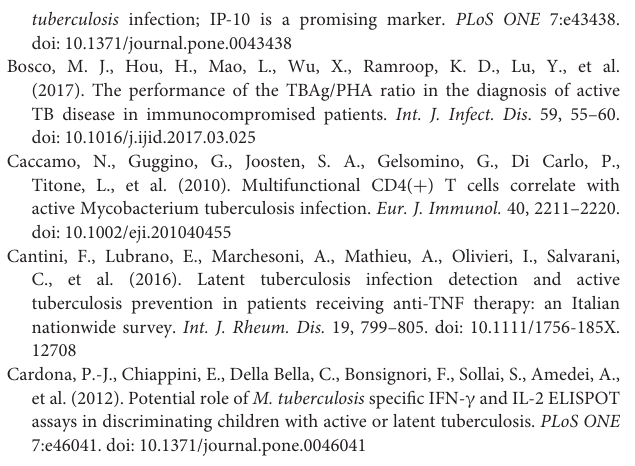
Supplementary Figure 1 | Flow cytometry gating strategy for CD4 + T cells, CD8 + T cells, NK cells, DC, and MON. Leukocytes were gated according to CD45 expression and side scatter (SSC). (A) CD4 + and CD8 + T cells were gated as CD3 + CD4 + and CD3 + CD8 + cells; (B) NK cells were gated as CD3-CD56 + cells; (C) DC were gated as CD3-CD19-CD56-HLA-DR + cells; (D) MON were gated as CD45 + CD14 + HLA-DR + cells. Supplementary Figure 2 | The secretion of TB-specific cytokines by lymphocytes analyzed with flow cytometry. The PBMCs isolated from ATB patients were stimulated with TB-specific antigens (ESAT-6 and CFP-10) for 24h. After stimulation, the cells were collected for analysis of intracellular IFN- γ and TNF- α in CD4 + T, CD8 + T and NK